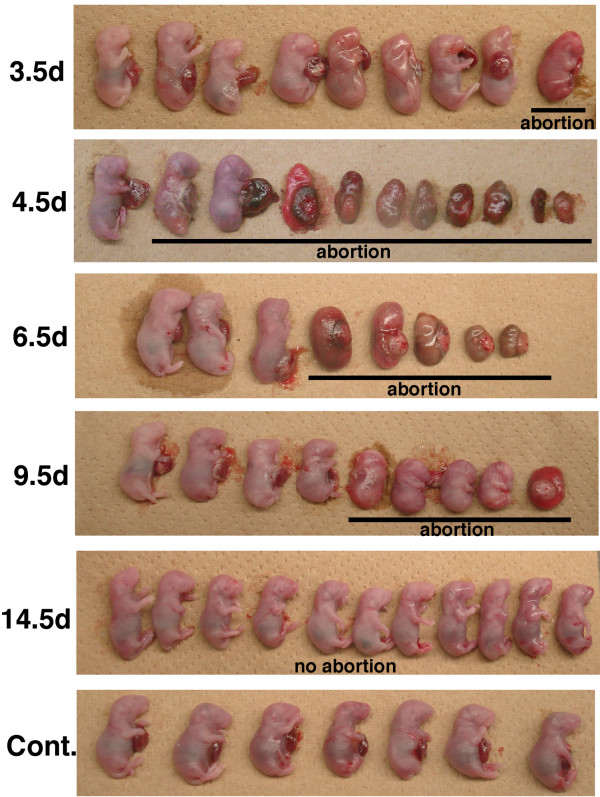
B. abortus infection causes abortion in pregnant mice. Groups of four pregnant mice were infected with bacteria intraperitoneally at each gestation time point. On day 18.5 of gestation, their fetuses were removed. Fetuses were determined to be alive if there was a heartbeat, and dead if there was no heartbeat. Fetuses underlined were aborted.